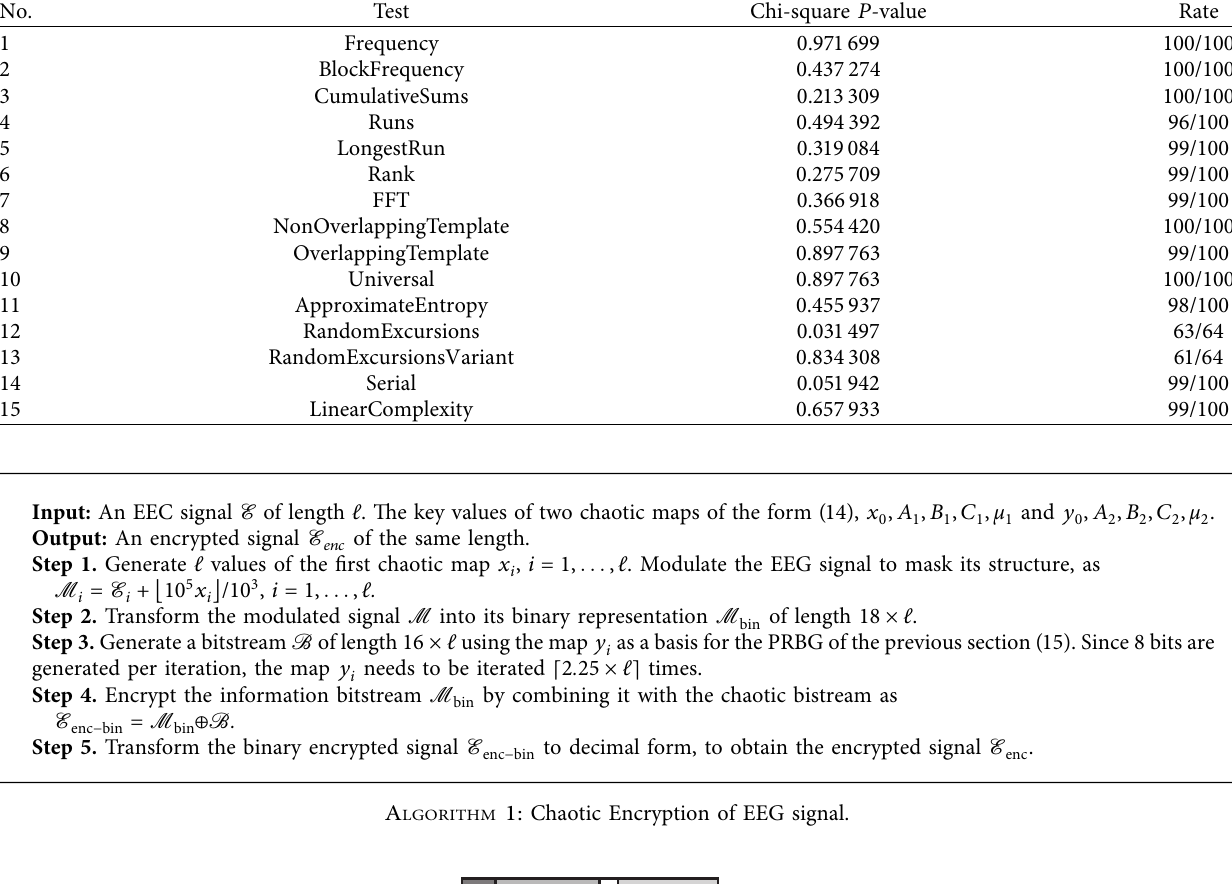
Table 1: NIST test results ( x